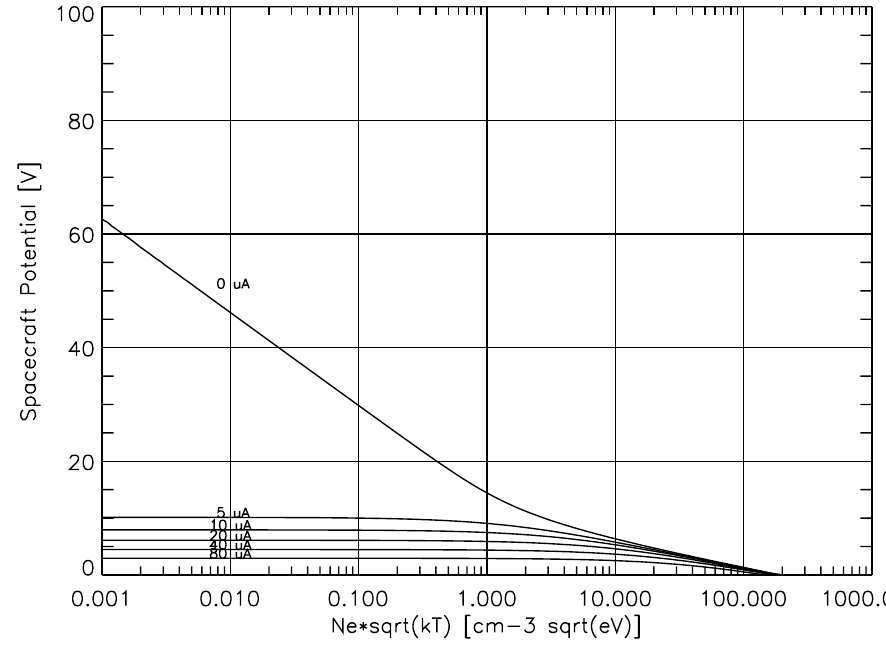
Fig. 1. Effect of an ion beam from 0 to 80 µ A on the spacecraft potential of